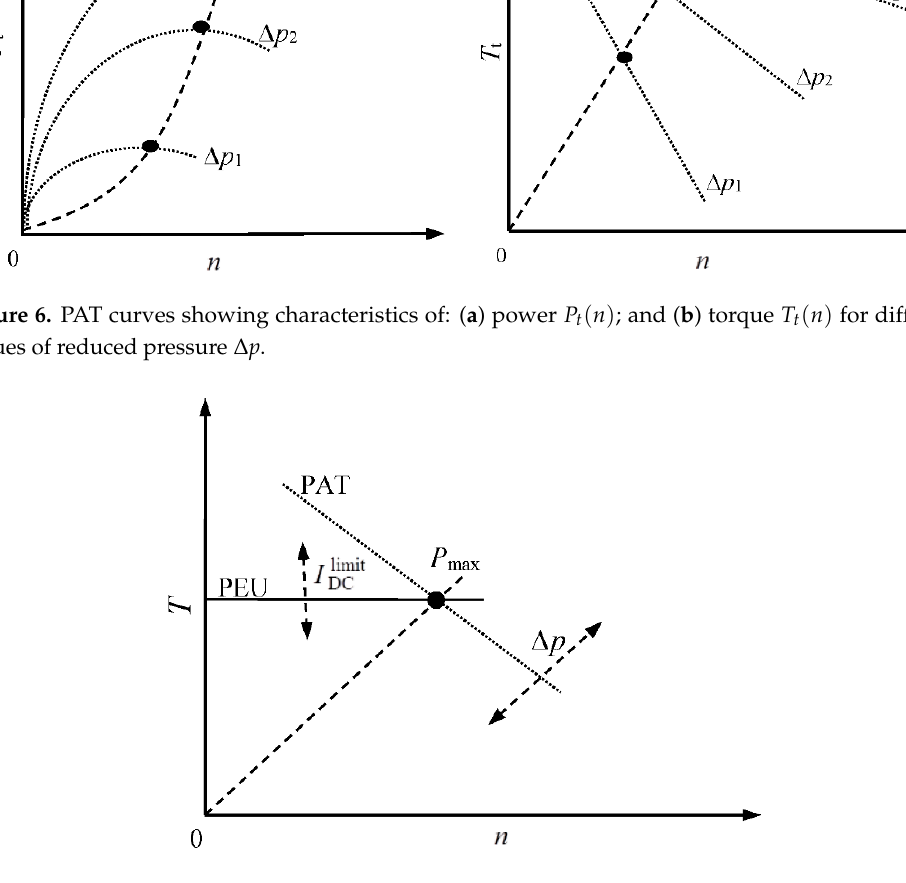
Figure 7. Location of optimal operation point according to torque characteristic (PEU and PAT) .